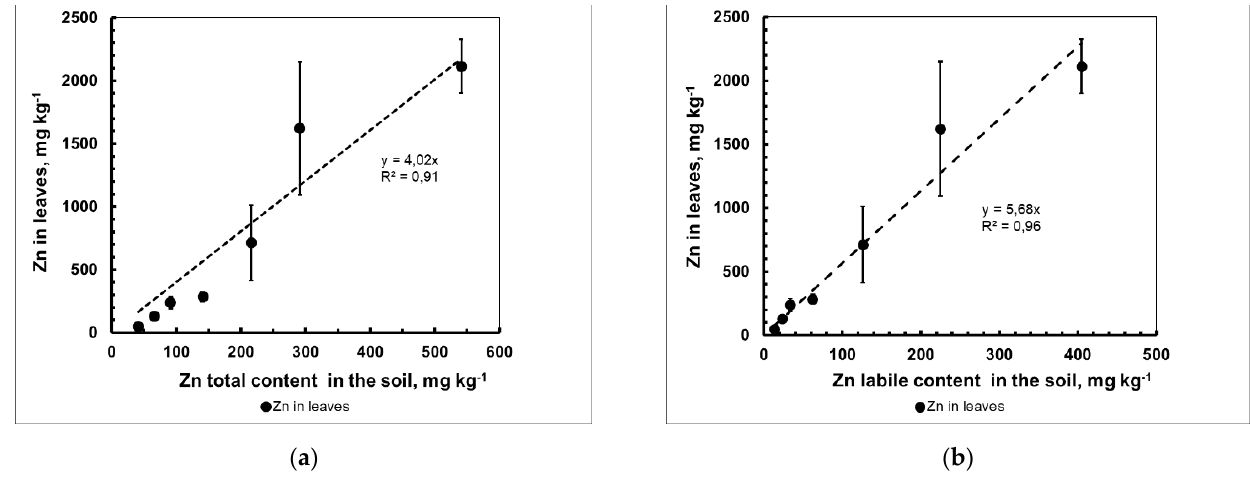
Figure 4. Dependence of the mass concentration of Zn in the phytomass of 21-day-old barley plants on the total amount ( a ) and labile form ( b ) of the metal in the soil (mean value ± standard deviation; n = 3).